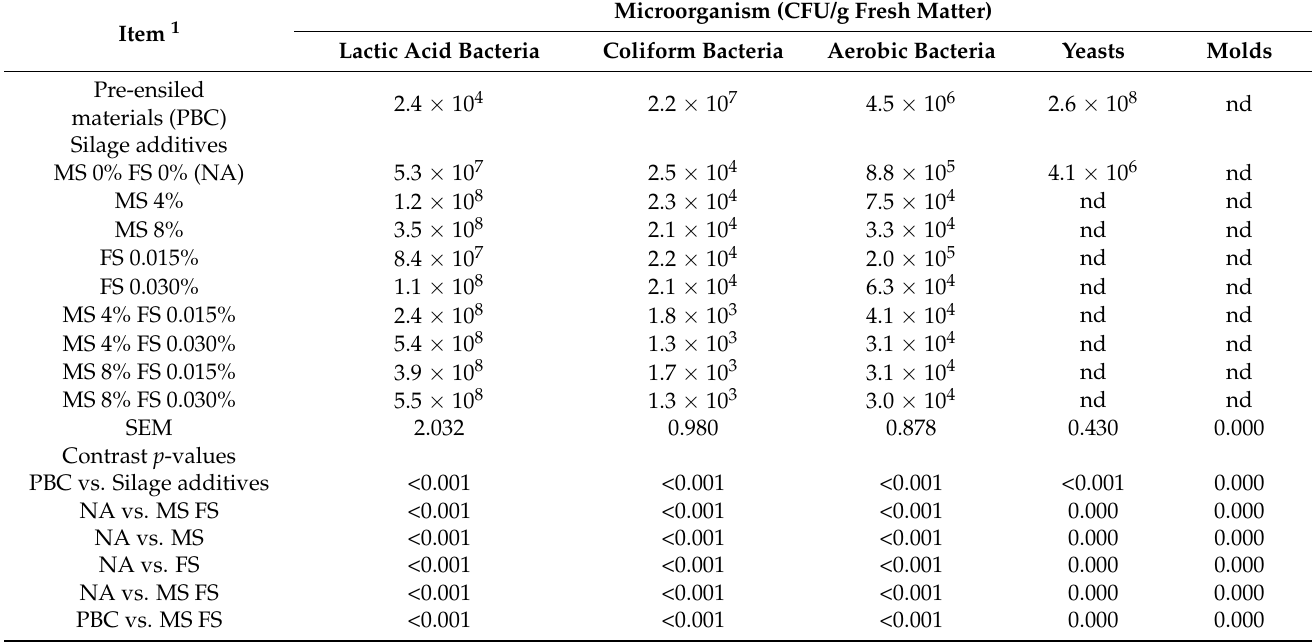
Table 3. Microorganism counts of anthocyanin-rich black cane prior to ensiling (pre-ensiled materials) and its silages at 42 d after